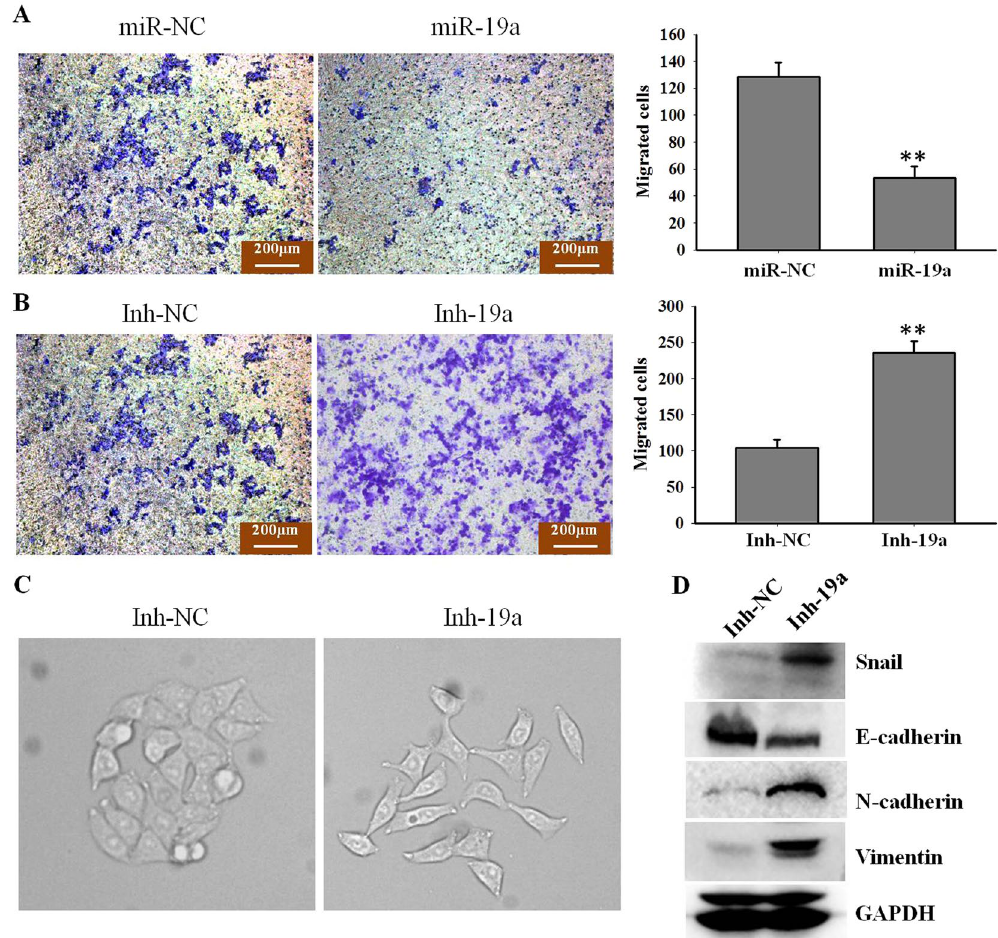
Figure 3. miR-19a contributes to EMT in NSCLC cells ( A ). A549 cells were treated with gefitinib (5 μ M) and then transfected with miR-19a or miR-NC; after 24 h, cell migration was detected with a transwell assay. Migrated A549 cells were stained with crystal violet (left); miR-19a overexpression significantly decreased cell migration; quantified data are shown on the right. ** p < 0.01; ( B ) A549 cells were treated with gefitinib (5 μ M) and then transfected with Inh-19a or Inh-NC; after 24 h, cell migration was detected with a transwell assay, and migrated A549 cells were stained with crystal violet (left); miR-19a down-regulation significantly increased cell migration; quantified data are shown on the right. ** p < 0.01; ( C ) A549 cells were treated with gefitinib (5 μ M) and then transfected with Inh-19a or Inh-NC; the cell morphology is shown. The Inh-19a group exhibited spindle-shaped cells and loss of cell-cell contact, which suggested EMT; ( D ) A549 cells were treated with gefitinib (5 μ M) and then transfected with Inh-19a or Inh-NC, and EMT pathway markers were detected by western